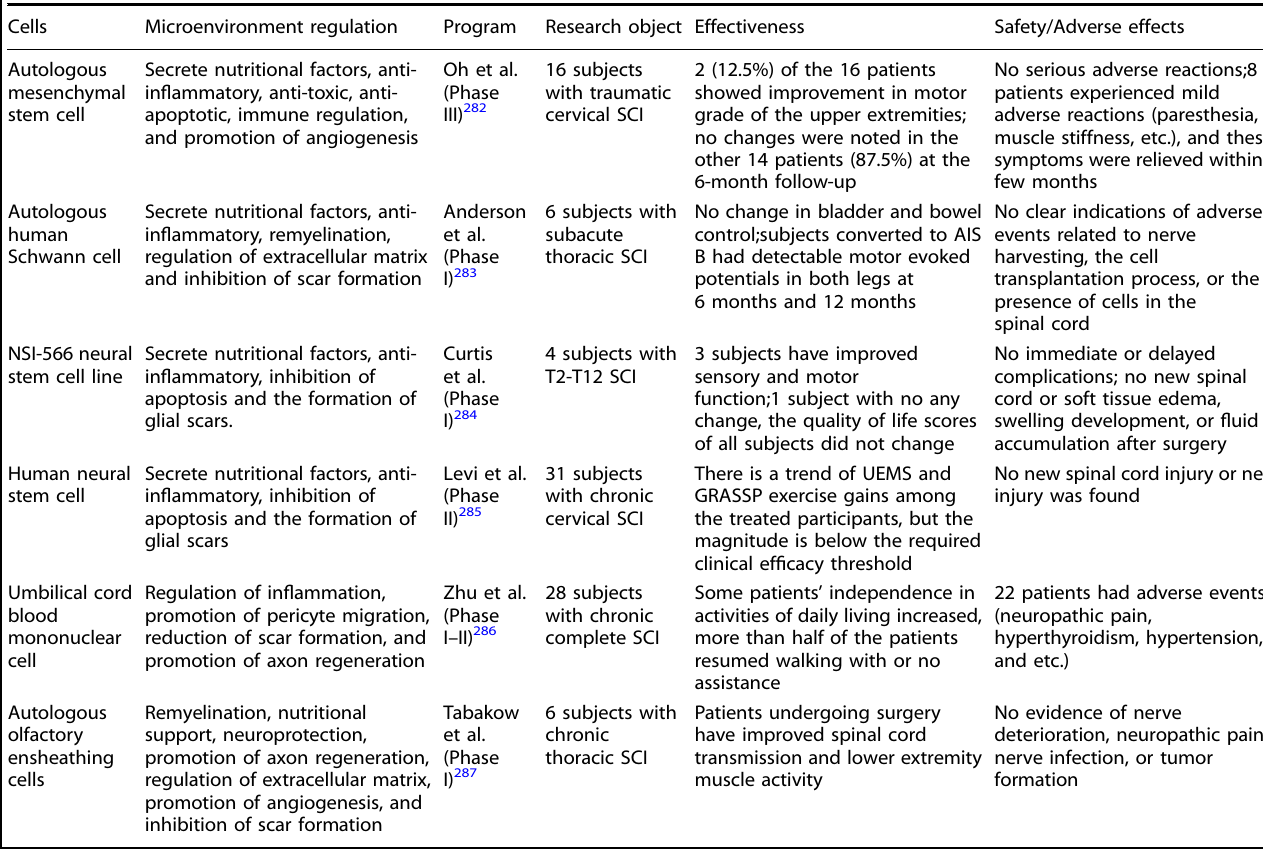
Table 2. Cell therapy for spinal cord